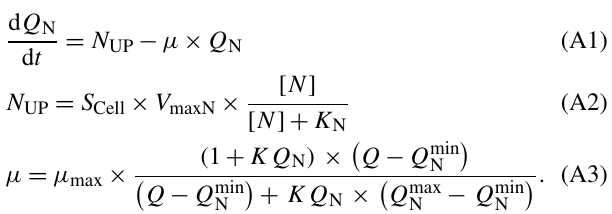
Figure A1. Cellular quota of nitrogen vs. the nitrate concentration using parameters of the best-fit results of the model ran for the low- light and nitrate-limited experiment with